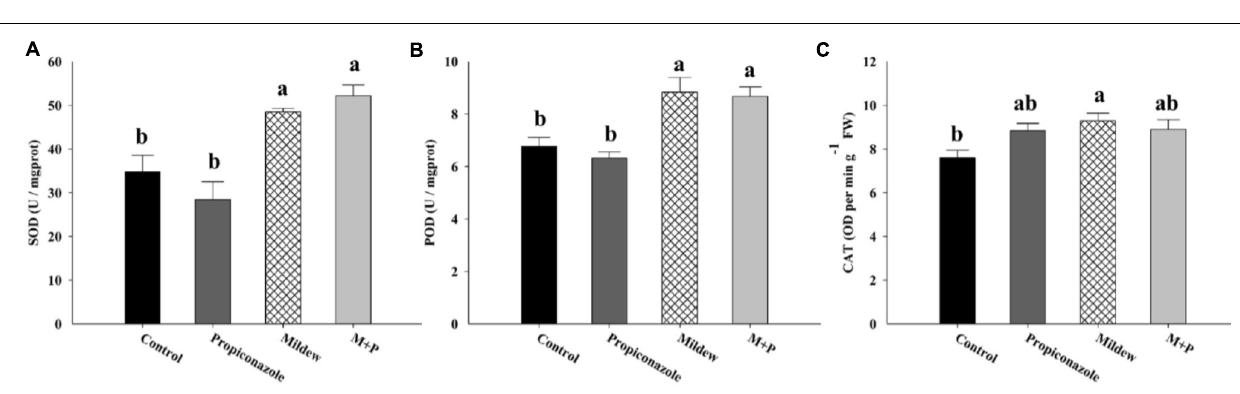
between mildew and M + P treatments for PAL , PR1 , PEROX , and NADPHOX . Conversely, compared to mildew treatment, the application of Propiconazole decreased the expression of PR2 and PR3 ( PR2 : P = 0.003, PR3 : P = 0.016; Figures 5C,D ). LOX ( Supplementary Figure S1